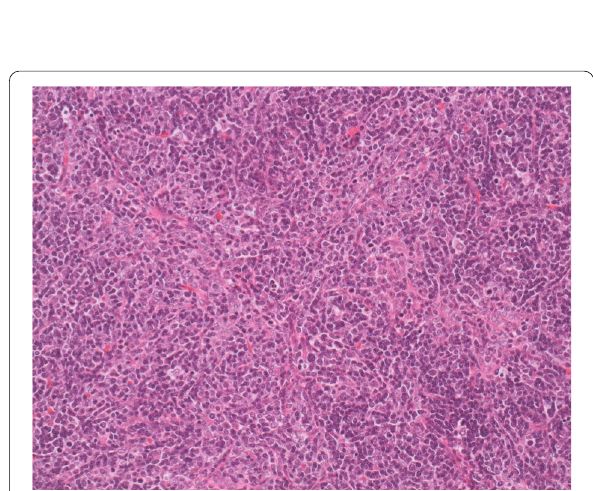
Fig. 5 Pathological examination. Pathological examination showed that the tumor was a thymoma. The nodule was a lobular tumor containing many T lymphocytes and some thymic epithelial cells and was covered by a fibrous capsule, which had been partially invaded by tumor cells. Thymic gland tissue was found in the surrounding fat tissue. Hematoxylin and eosin staining, ×